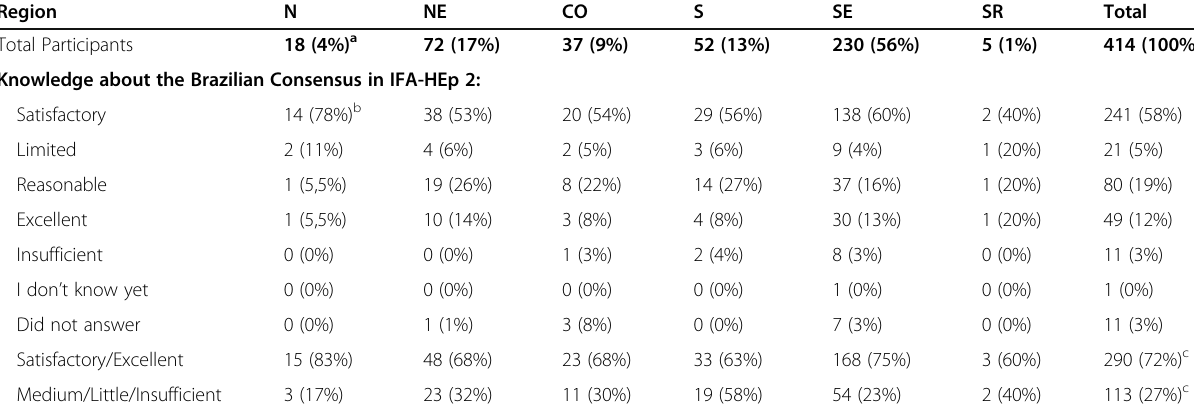
Table 2 Rheumatologists ’ self-assessment regarding knowledge about the Brazilian Consensus on antinuclear antibodies Region N NE